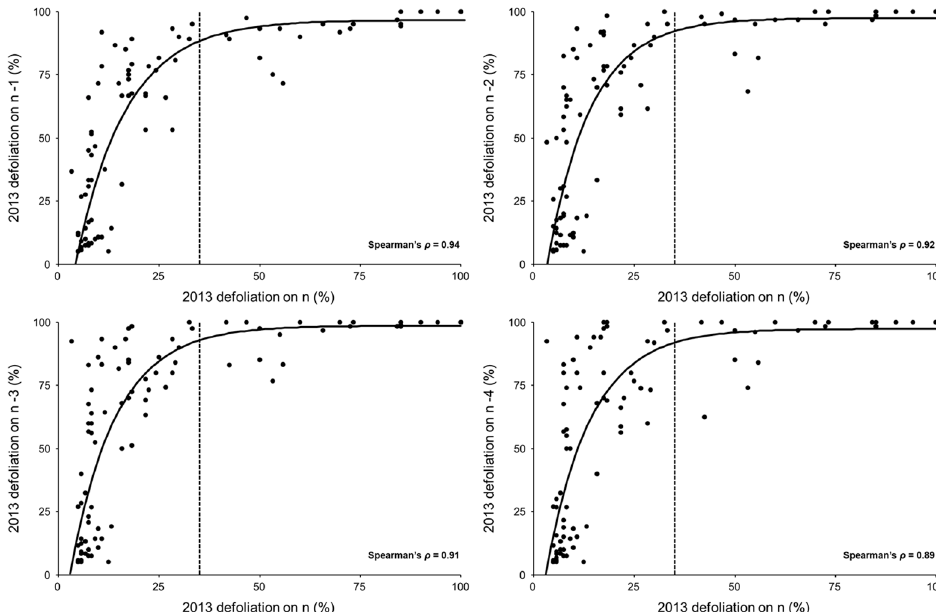
Figure 4. Relationships between defoliation on the current-year vs. previous-year shoots (n-1 to n-4) for the second year (2013) of the hemlock looper outbreak, as assessed using the field Fettes method. The vertical dotted line indicates the limit between the light and moderate to heavy defoliation.